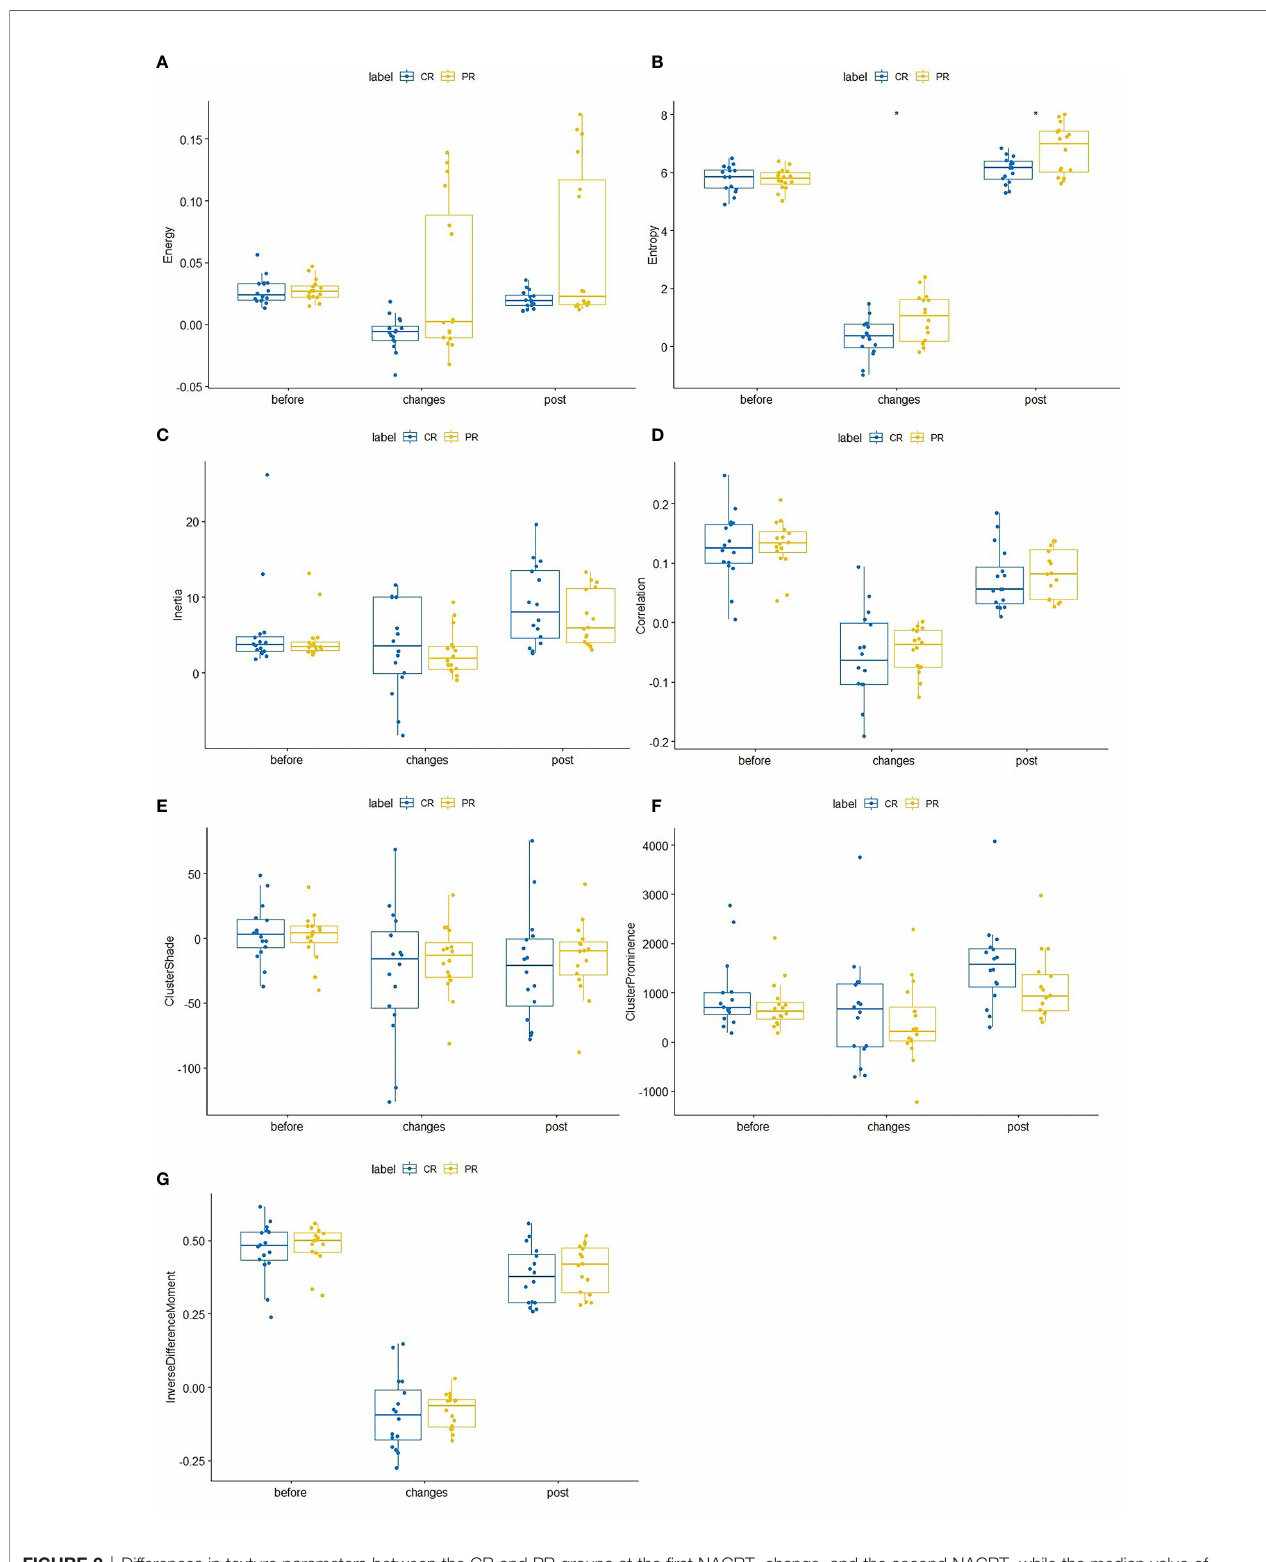
FIGURE 2 | Differences in texture parameters between the CR and PR groups at the fi rst NACRT, change, and the second NACRT, while the median value of relative texture parameter levels is displayed as a line within each box. (A – G) Energy, Entropy, Inertia, Correlation, Clustershade, ClusterProminence, InverseDifferenceMoment. AUC, area under the receiver operating characteristic curve; CI, con fi dence interval. * means signi fi cant